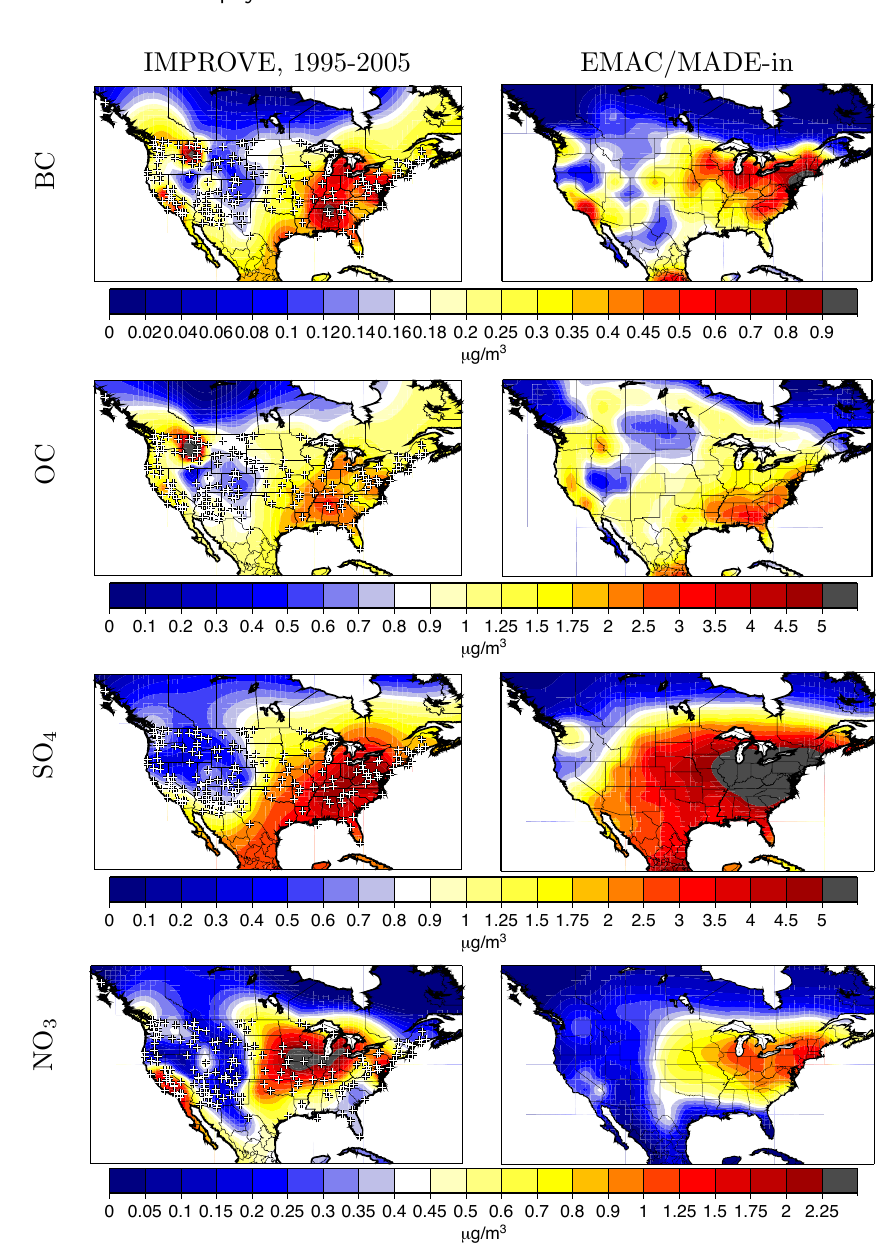
Fig. 4. Comparison of the climatological annual mean of BC, OC, SO 4 and NO 3 in PM 2 . 5 from observations by the IMPROVE network (left column) and EMAC/MADE-in (right column). The crosses indicate the locations of the measurement sites. See text for more details.